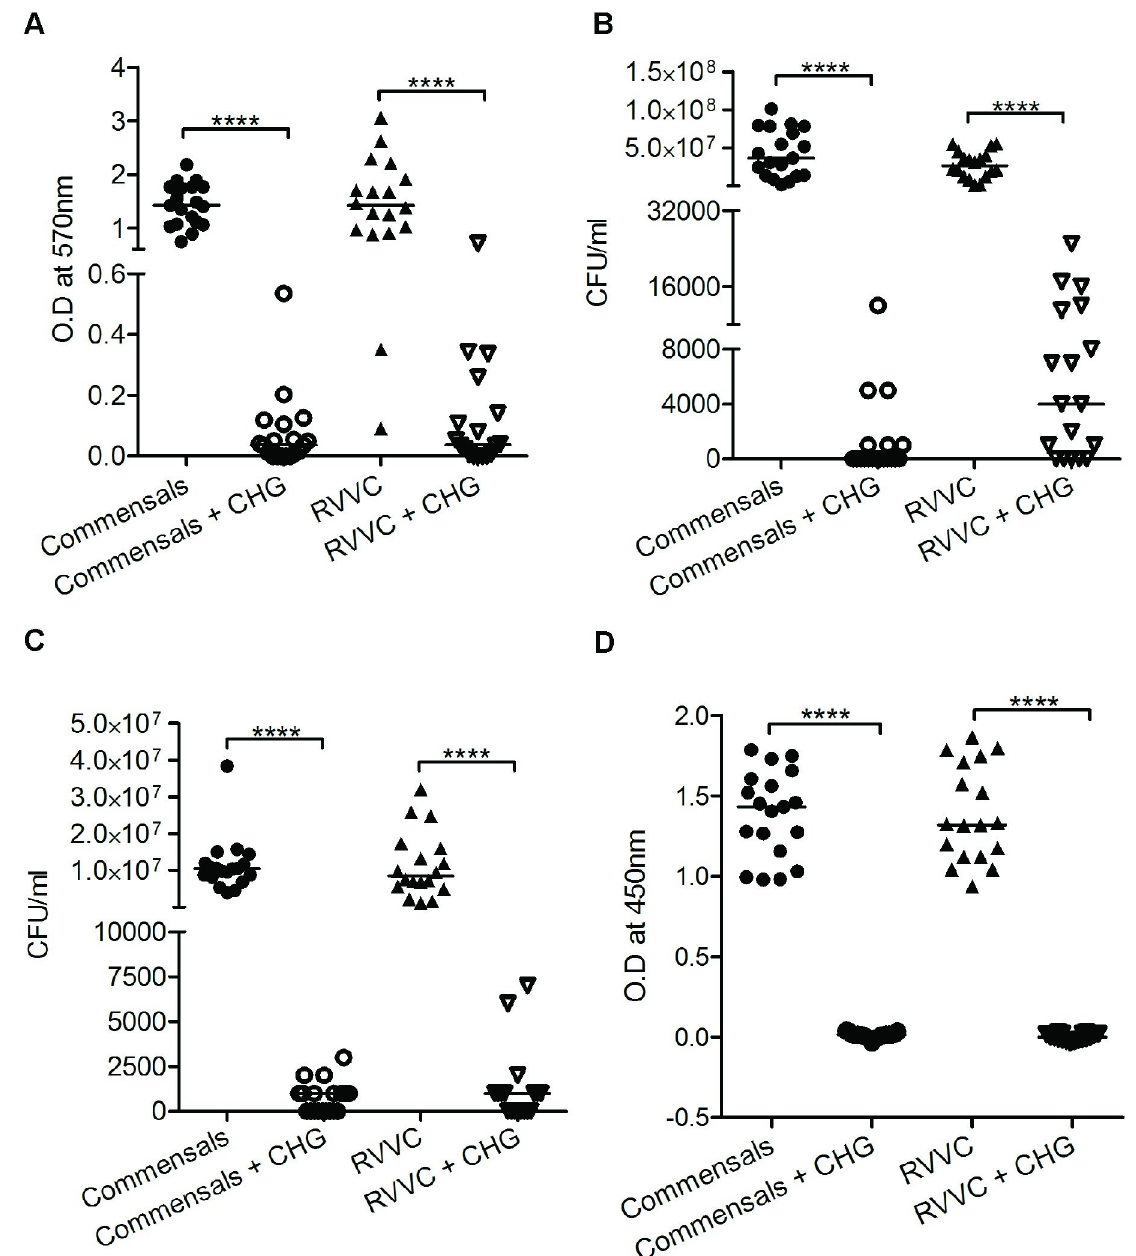
Fig 3. Chlorhexidine digluconate inhibits the formation of new biofilm and growth of C . albicans . The effect of chlorhexidine digluconate 0.02% was investigated on formation of new C . albicans biofilm using crystal violet assay ( A ). Viable count was shown for planktonic C . albicans ( B) and of C . albicans in newly formed biofilm ( C) . Metabolic active cells within the mature biofilm, measured with XTT assay (D). Untreated strains served as controls. Individual and median values are presented, depicted as optical density (OD) at 570 nm after dissolution of crystal violet, and at 450 nm for soluble product of formazan crystal after reduction of XTT. ���� p < 0.0001.